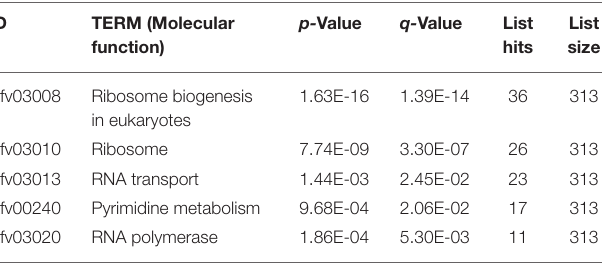
TABLE 2 | KEGG metabolic pathway enrichment analysis of differentially expressed genes when A. flavus was treated with